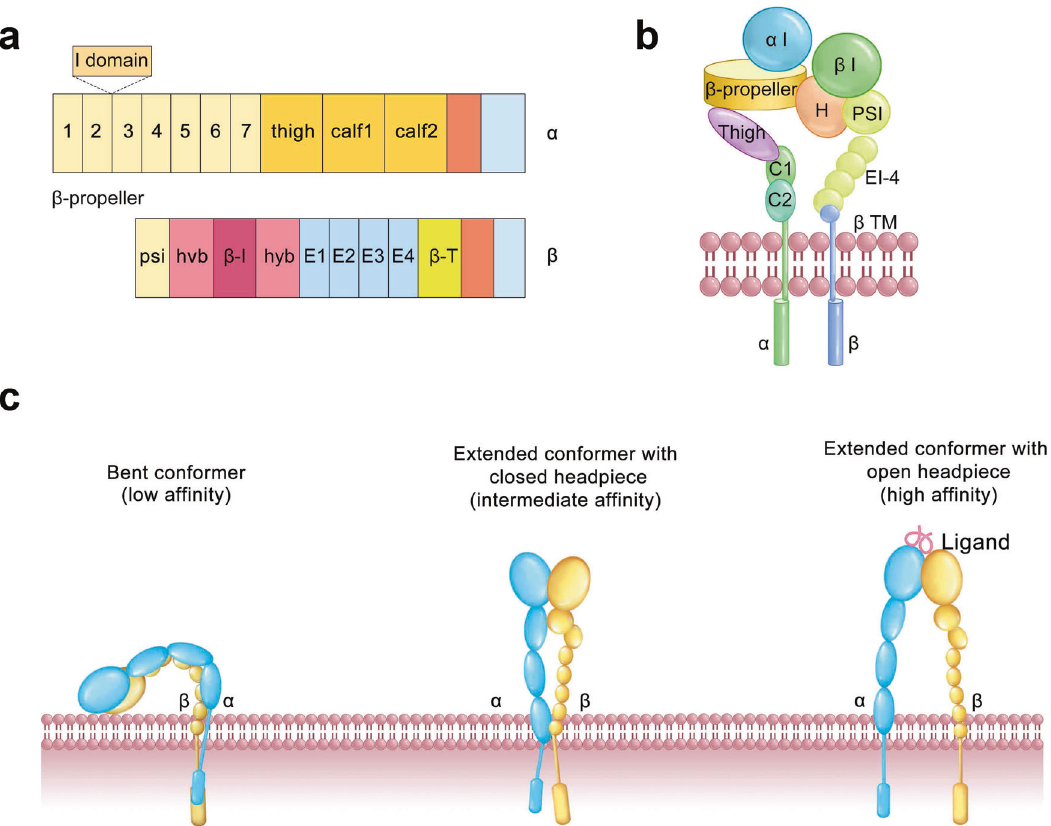
Fig. 2 The primary structure and representative conformations of integrins. a Organization of domains within the primary structures. b Arrangement of domains within the representative 3D crystal structure of integrins. c Conformational change of integrins: bent closed, extended – closed, and extended open